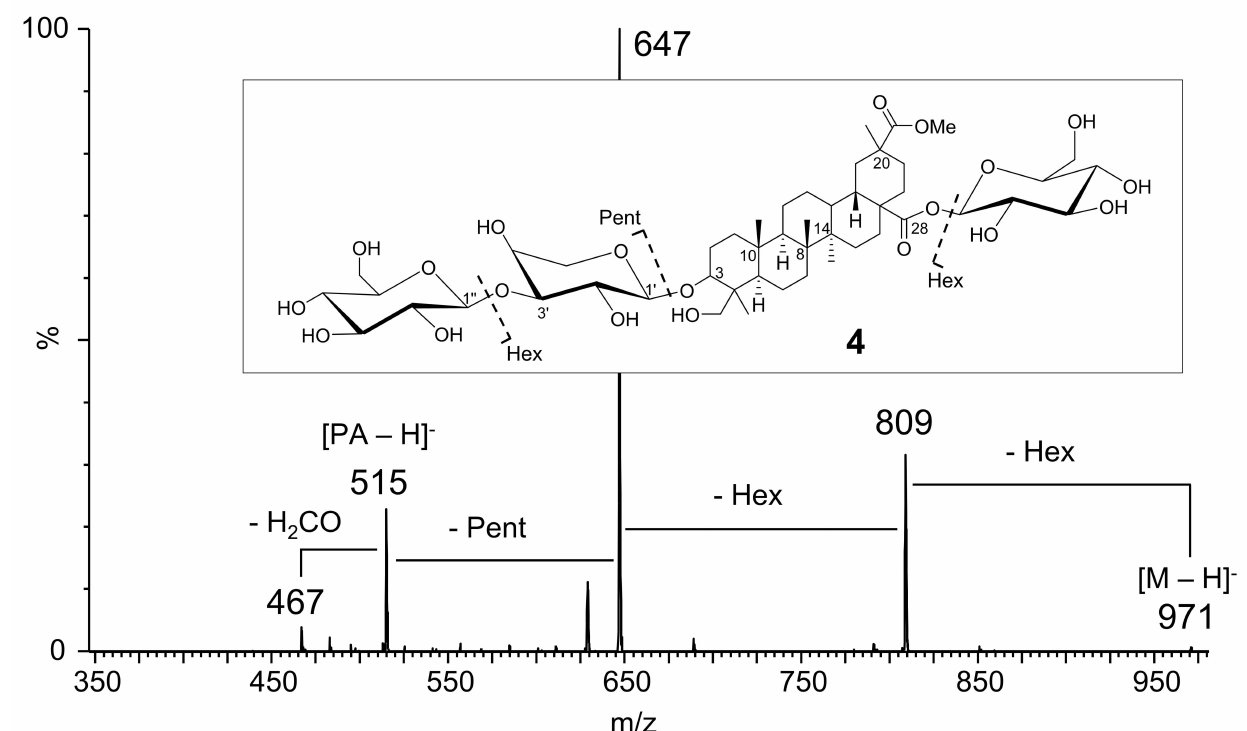
Figure 4. Product ion spectrum on [M-H] − of compound 4 (m/z 971), which was identified in genotype AZ-129. The fragment ion series m/z 809, 647, and 515 show the consecutive loss of sugar units from the saponin as is indicated in the inserted structural formula. The fragment ion m/z 515 is characteristic of phytolaccagenic acid as the